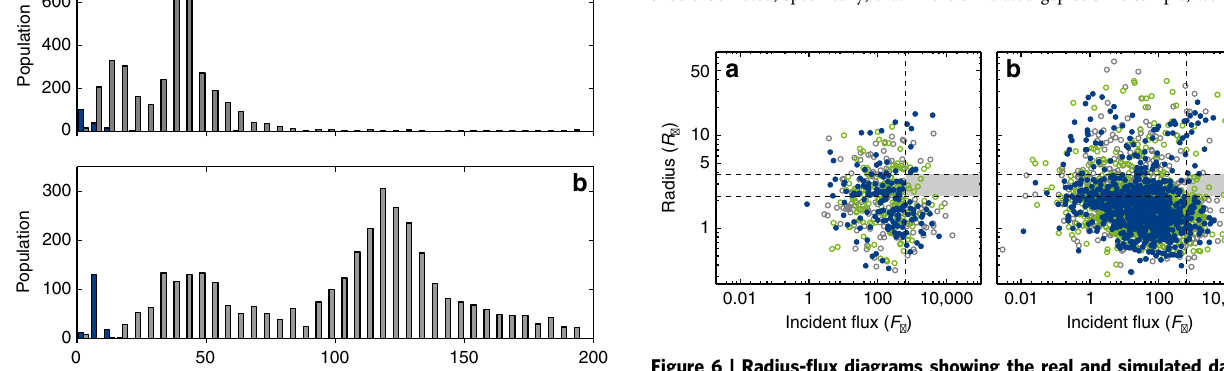
Figure 6 | Radius-flux diagrams showing the real and simulated data. ( a ) One draw of the 157 exoplanets in the seismic subsample (filled blue cicles) as well as a model of the subsample made from the Gaussian Figure 5 | Distribution of uncertainties on radius and incident flux. mixture model with (grey open circles) and without an artificial gap (green Histogram showing the distribution of the relative uncertainty in radius ( a ) open circles). The vertical dashed line shows where the incident flux is and incident flux ( b ) for both the seismic and the non-seismic sample. The equal to 650 F " , while the horizontal dashed lines indicate radii of 2.2 and seismic sample is shown in blue and the non-seismic sample is shown in grey. Note the bimodal distribution in the non-seismic sample and the low 3.8 R " , respectively. The location of the hot-super-Earth desert has been uncertainties in the seismic sample compared with the non-seismic one. shaded. ( b ) Same, but for the non-seismic sample. NATURE COMMUNICATIONS|7:11201|DOI: